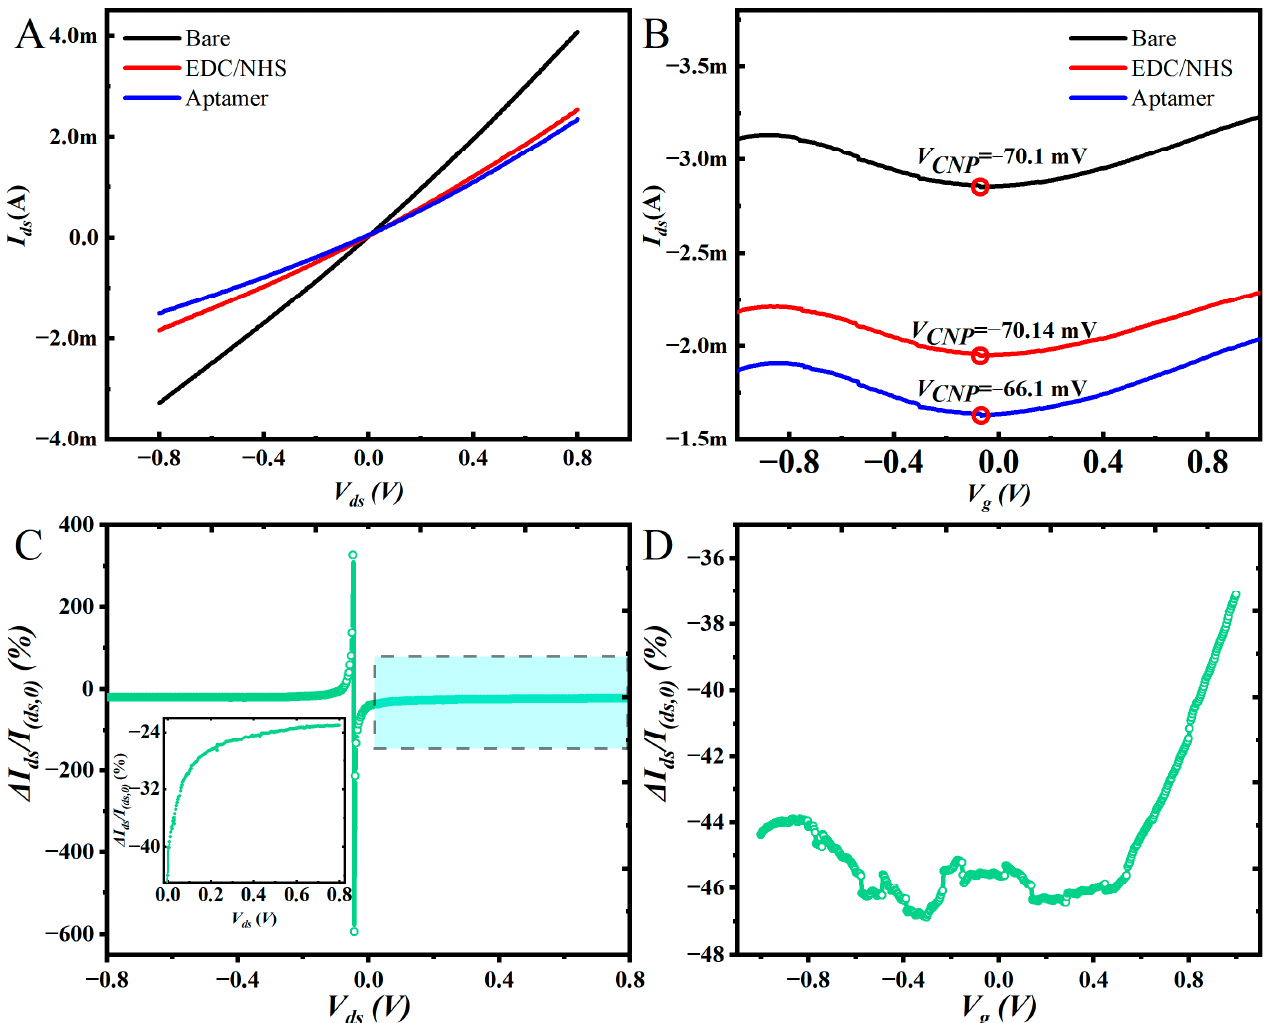
and the value of V ds was controlled at − 0.8 V. The results are shown in Figure 3B, which indicates that V CNP of bare Eg-GFET is − 70.1 mV. After EDC/NHS treatment, V CNP is shifted in the left direction to − 70.14 mV, and the aptamer immobilization makes V CNP move right slightly to − 66.1 mV due to the negative charges on the phosphate backbone of aptamer molecules [27]. Compared to the bare Eg-GFET, the transfer curves after being treated by EDC/NHS and modified by the aptamer are lowered. This may be caused by the reduced carriers’ concentration, which is consistent with the results of the output curve.